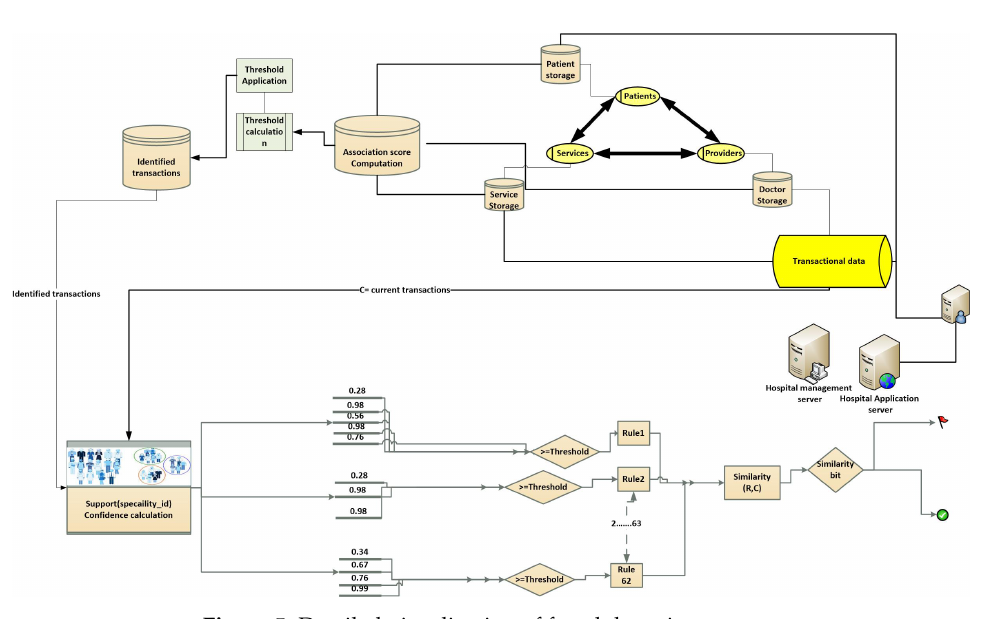
Figure 5. Detailed visualization of fraud detection system.